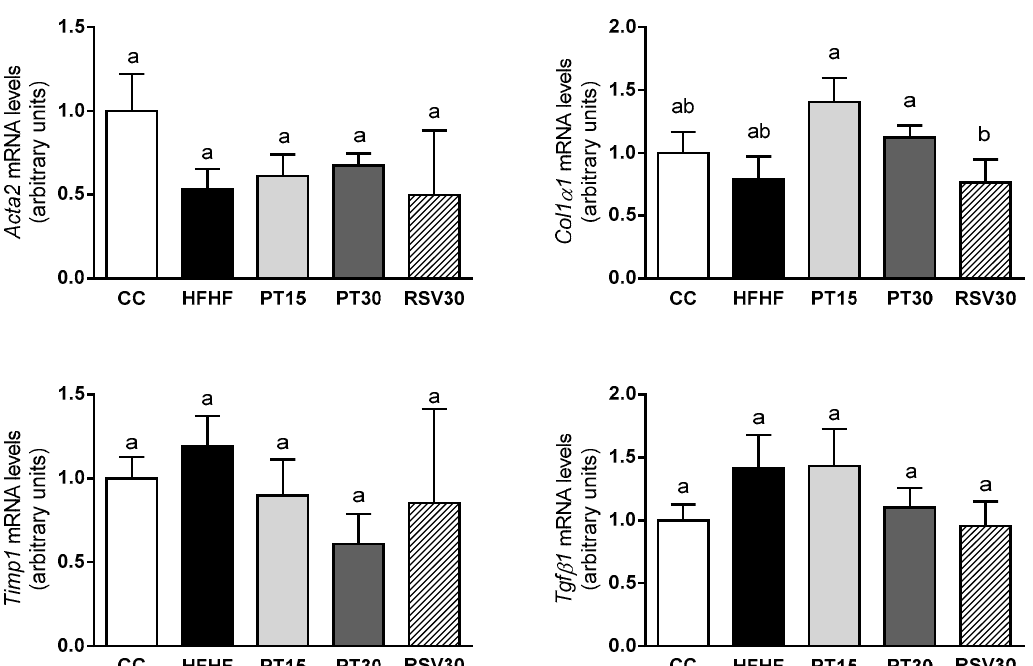
Figure 4. Acta2 , Col1a1 , Timp1 and Tgf β 1 mRNA levels in the livers from the rats fed with a control diet (CC group), a high-fat high-fructose diet (HFHF group), a high-fat high-fructose diet supplemented with pterostilbene at a dose of 15 mg / kg body weight / d (PT15 group), a high-fat high-fructose diet supplemented with pterostilbene at a dose of 30 mg / kg body weight / d (PT30 group) or a high-fat high-fructose diet supplemented with resveratrol at a dose of 30 mg / kg body weight / d (RSV30 group). Values are presented as mean ± SEM. Bars not sharing common letters a,b are significantly di ff erent ( p < 0.05). Acta2 : α -smooth muscle actin; Col1a1 : collagen 1; Timp : tissue inhibitor of matrix metalloproteases; Tgf β 1 : transforming growth factor